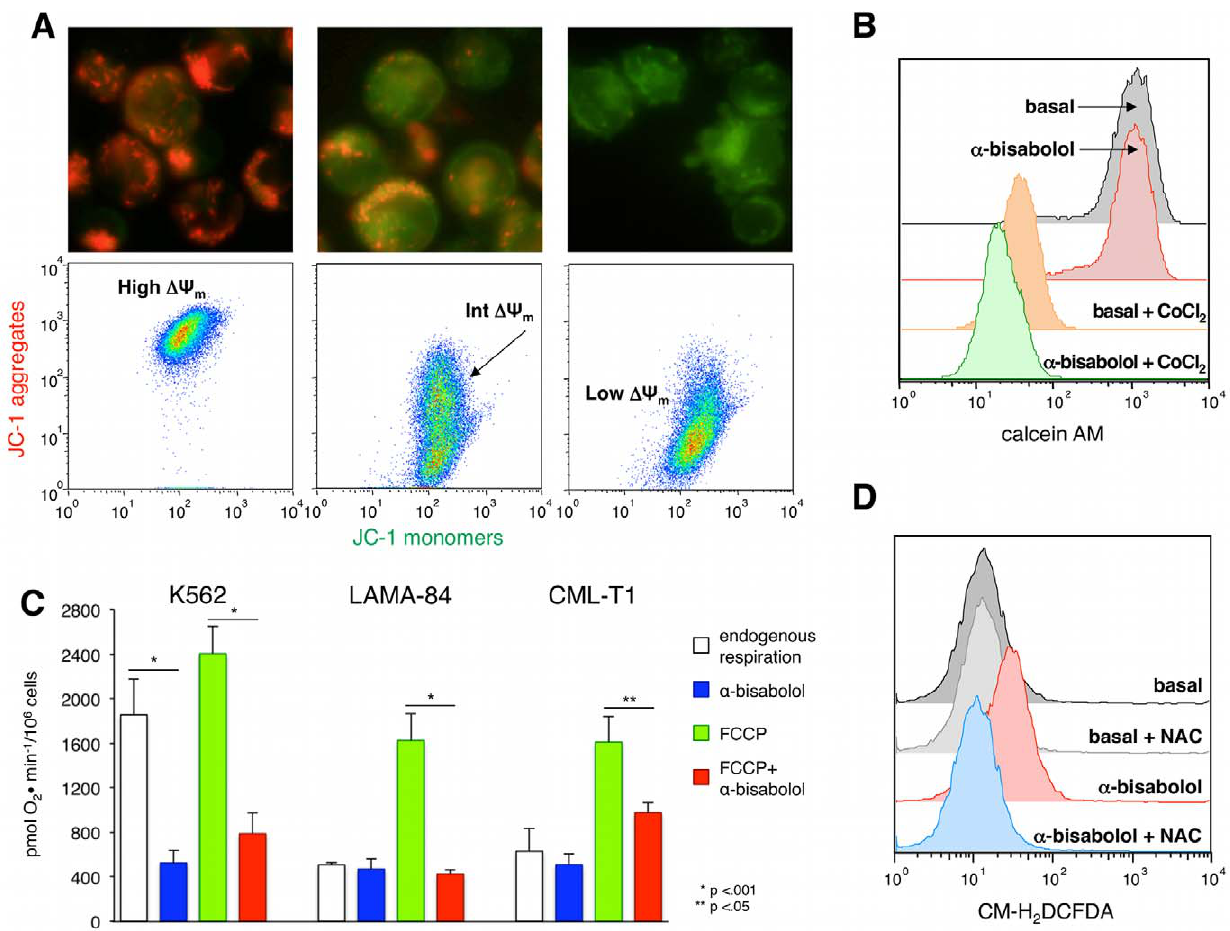
Figure 6. a -bisabolol determined damage to mitochondria in BCR-ABL + cell lines. (A) JC-1 staining demonstrated that a -bisabolol caused dissipation of mitochondrial transmembrane potential ( DY m ). Fluorescence microscopy (400x) . Untreated CML-T1 cells showed intact, well-polarized mitochondria, marked by a red punctate fluorescence; after treatment with 40 m M a -bisabolol for 3 and 5 hours there was a reduction of the red fluorescence and an increase of the green one, indicating loss of DY m . Flow cytometry . Untreated CML-T1 cells presented a normal (high) DY m . After treatment with 40 m M a -bisabolol for 3 and 5 hours they moved downward (intermediate and low DY m ) because of progressive JC-1 dislocation from mitochondria to the cytosol. (B) Calcein AM assay demonstrated the impairment of mitochondrial permeability transition pore (mPTP) function. After 5 hours of treatment with 40 m M a -bisabolol, CML-T1 cells were loaded with calcein AM: the intensity of fluorescence was similar to that of untreated cells. After adding CoCl 2 the fluorescence was lower in treated than in untreated cells, indicating that CoCl 2 entered damaged mitochondria and quenched calcein. (C) Intact BCR-ABL + cells were assayed for oxygen consumption at 30 u C in DMEM. Endogenous respiration in presence of FCCP (uncoupled respiration) was significantly inferior in cells treated with 40 m M a -bisabolol for 24 hours than in untreated cells. The results are mean 6 SD of 3 experiments for each cell line. (D) a -bisabolol induced striking generation of ROS in CML-T1 cells after treatment with 40 m M a -bisabolol for 5 hours. This was completely abrogated by the presence of NAC. Each shown experiment in panels A, B, and D is representative of